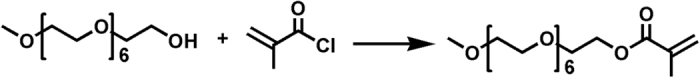
The synthesis route of EO precursor.